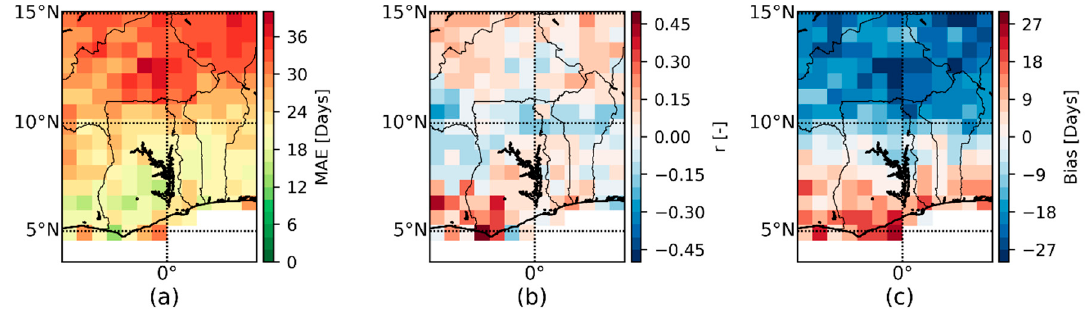
Figure 9. Forecast accuracy, skill and bias for ORS dates for each grid cell based on ( a ) mean absolute error (MAE); ( b ) Pearson’s correlation r and ( c ) bias. Mean of 15 ensemble members of SYS4 (initialized in February) in comparison to CHIRPS, 2000–2010.